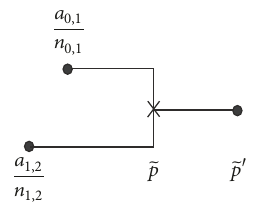
Figure 1: Three-point interaction.